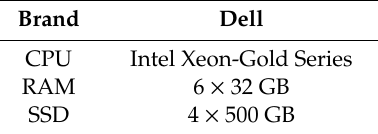
Table 6. MOELC physical ad FC-EC-SG virtual Servers Specifications.